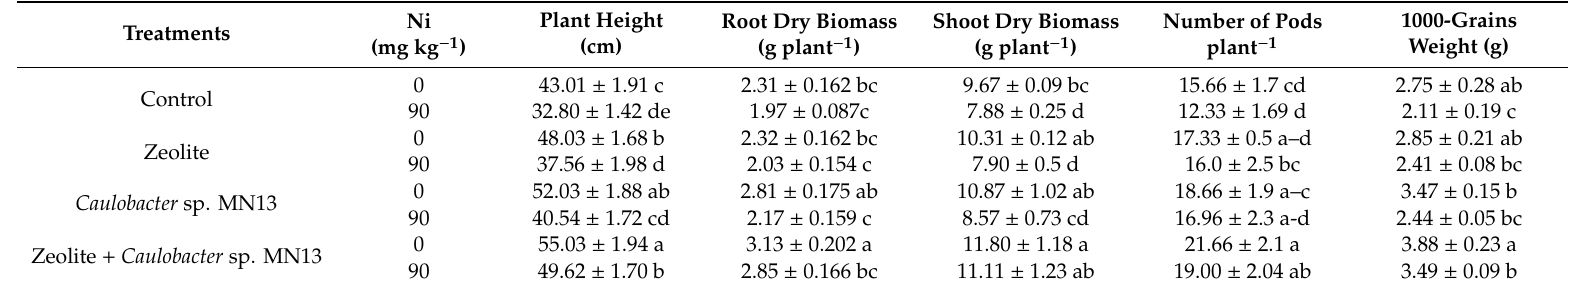
Table 2. E ff ect of Caulobacter sp. MN13 and zeolite on growth and yield of sesame grown in normal and Ni contaminated soil.